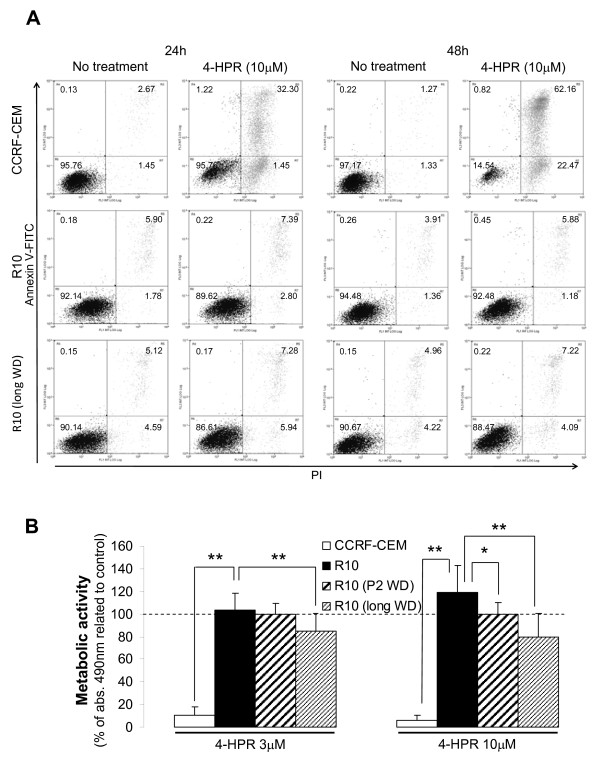
Effect of drug withdrawal on cell resistance. (A) Parental sensitive CCRF-CEM cells, resistant R10, and long-term drug withdrawn resistant (R10 longWD) cells were treated and cell death determined by annexin V-FITC/propidium iodide staining at the selected time points. Values represent the percentage of cells in each quadrant. Representative data from two independent experiments are shown. (B) A portion of each sample for SL profile analysis (Figure 5) was saved for XTT assay estimation of resistance. Briefly, R10 cells after 48 h and long-term drug withdrawal were subjected to 48 h treatment with 3 or 10 μM 4-HPR. All data were related to the corresponding untreated cells. Statistical analysis was related to R10 data. Data are average ± SD of 12 values from to three independent experiments. *P < 0.05; **P < 0.01; ANOVA plus Tamhane post-hoc test.